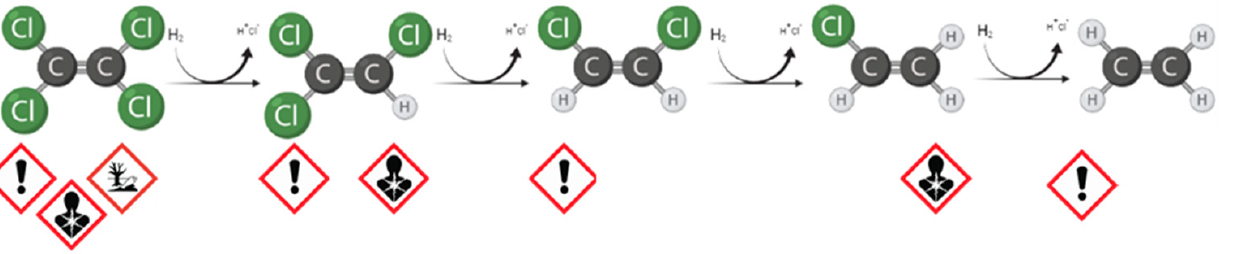
Figure 1. Step-by-step reductive dechlorination (RD) and hazard pictograms associated with each compound. Created with Biorender.com (accessed on 1 April